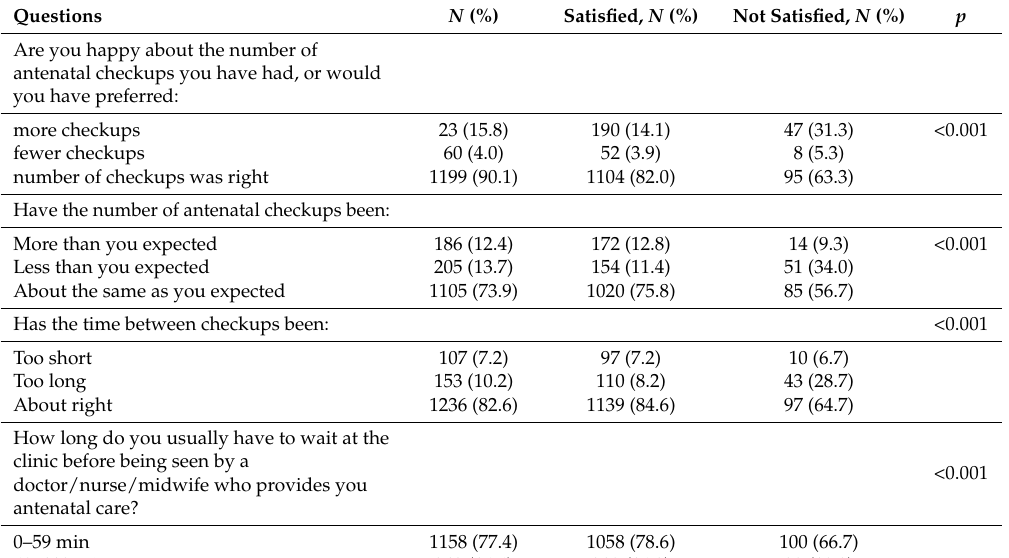
Table 2. Bivariate associations between satisfaction by antenatal care and answers to the questions on the antenatal